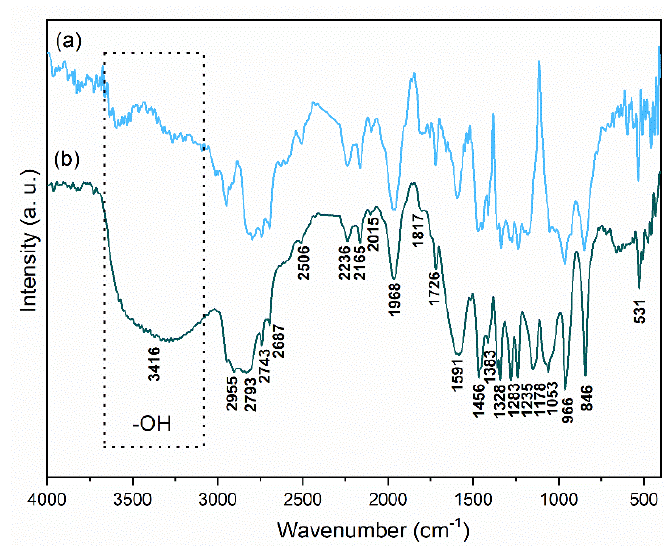
Figure 2. FTIR spectra from the conditions of experimental design resulting in the obtention of samples ( a ) 5 and ( b ) 12, at room temperature. Table 3. Wavenumbers and assignments of IR bands exhibited by samples 5 and 12. Where, ν = stretch, δ = scissor / deformation, ω = wag, ρ = rock, τ = twist. The subscripts s and as refer to symmetric and asymmetric vibrational modes,